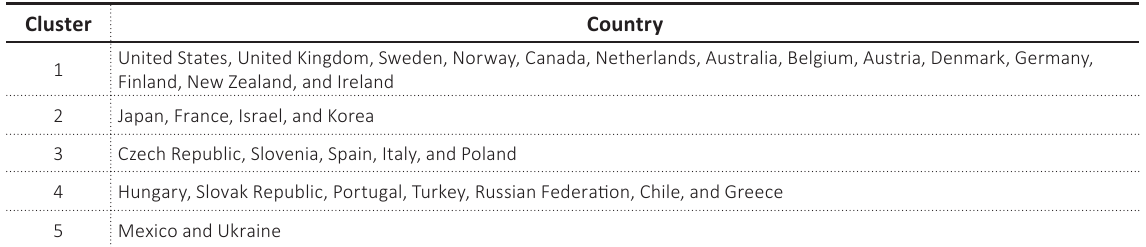
Source: Processed by authors in IBM SPSS